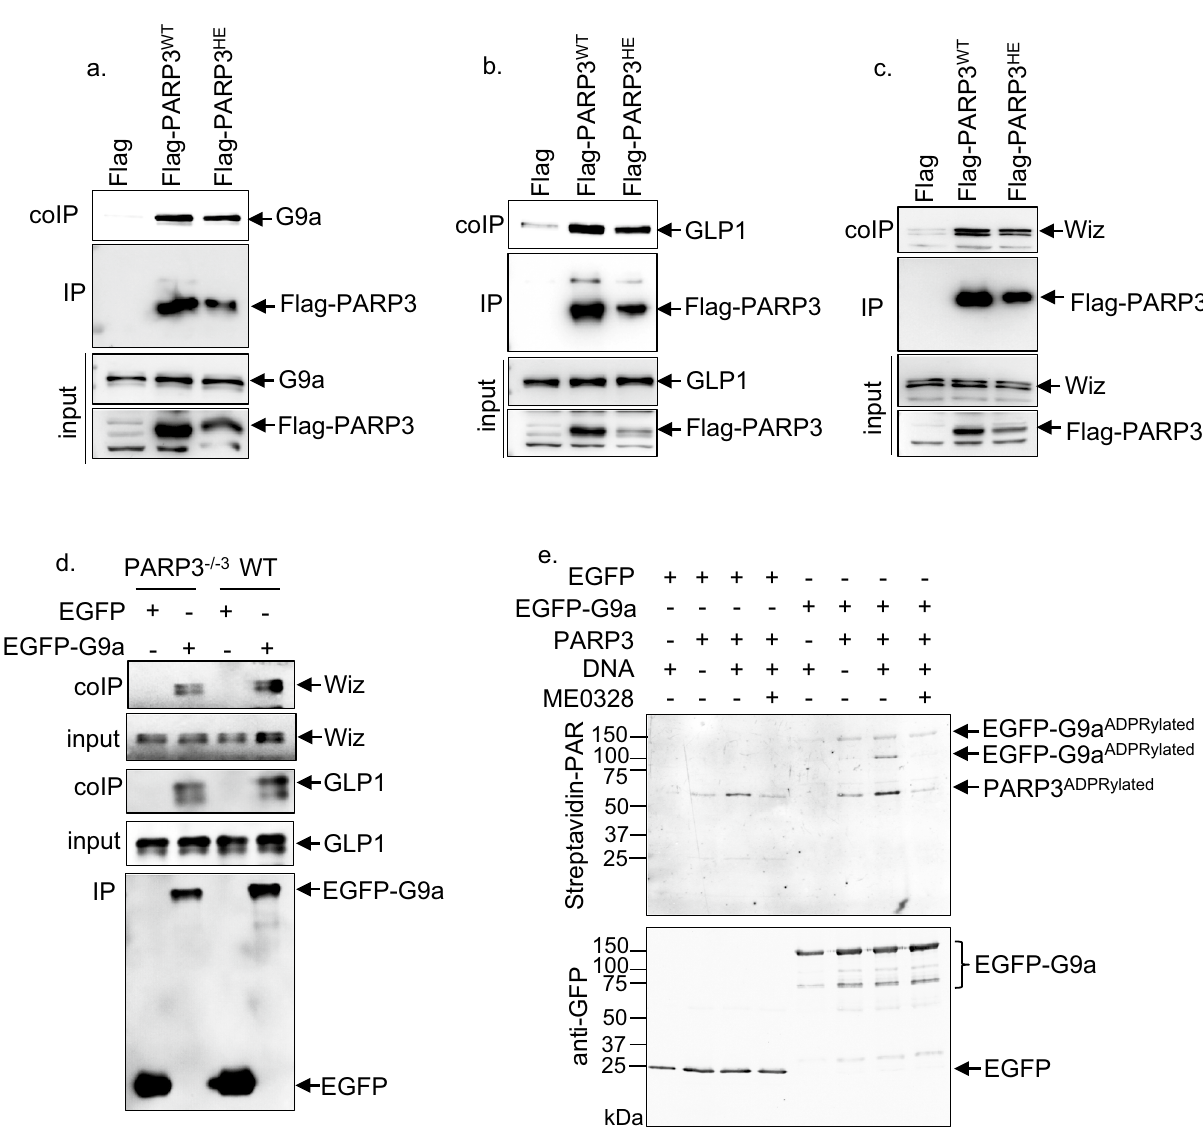
Figure 2. PARP3 interacts with and ADP ribosylates G9. ( a–c ) G9a, GLP1 and Wiz co-immunoprecipitate with Flag-PARP3 WT and Flag-PARP3 HE but not with Flag. The PARP3 −/−3 -Flag, PARP3 −/−3 -Flag-PARP3 WT and PARP3 −/−3 -Flag-PARP3 HE LN229 cell extracts were immunoprecipitated with a Flag antibody and analysed by western blotting using anti-G9a ( a ), anti-GLP1 ( b ), anti-Wiz ( c ) and anti-Flag antibodies. Input corresponds to 1/40 of the total amount of cell extracts used for immunoprecipitation. ( d ) The absence of PARP3 does not alter the stability of the G9a/GLP1/Wiz complex. The parental (WT) and the PARP3 −/−3 LN229 cells were transfected with either EGFP (control) or EGFP-G9a. EGFP and EGFP-G9a immunoprecipitates were analysed by western blotting using anti-Wiz, anti-GLP1 and anti-EGFP antibodies. Input corresponds to 1/30 of the total amount of cell extracts used for immunoprecipitation. ( e ) PARP3 ADP-ribosylates G9a in vitro. Immunopurified EGFP (control) or EGFP-G9a were incubated with purified PARP3 in the absence or in the presence of DNase- activated DNA and biotinylated NAD + . When indicated ME0328 (20 µM) was added in the reaction buffer to inhibit PARP3 catalytic activity. ADP-ribosylated G9a and PARP3 (auto-ADP-ribosylated) are detected using the streptavidin Alexa system. EGFP and EGFP-G9a are detected by western blotting using an anti-GFP antibody. Uncropped Western-blots are shown in the supplementary information